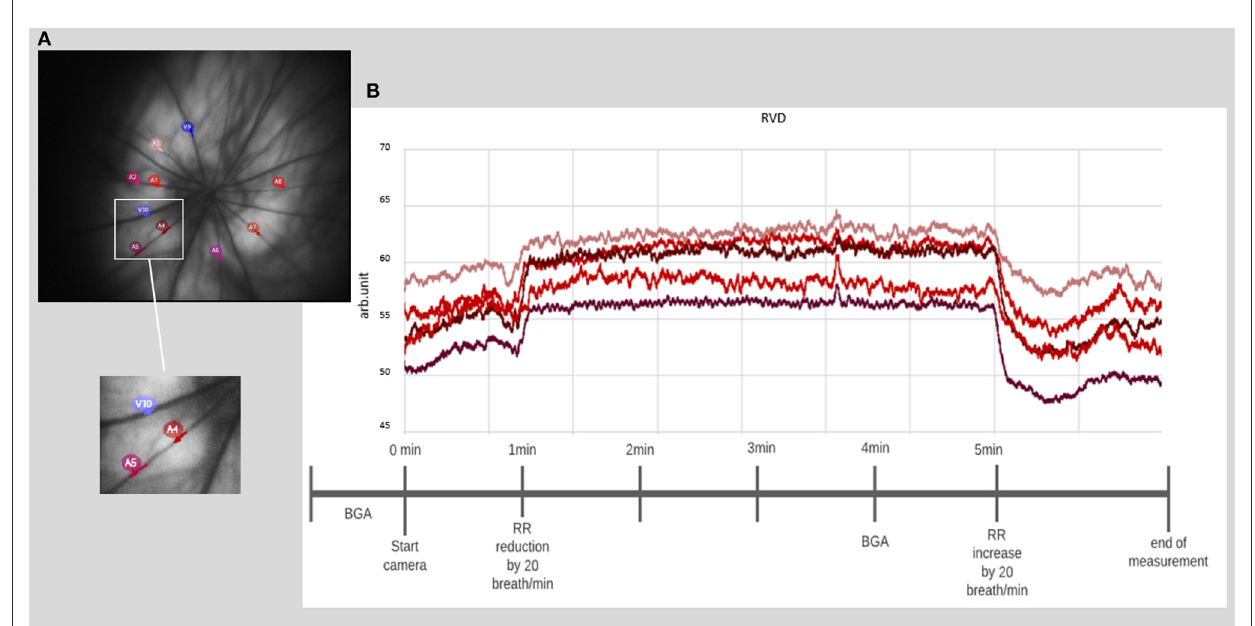
FIGURE4 Retinal vessel diameter measurement. (A) Example of a fundus image with the selection of 10 different vessel segments. (B) Example of a time course of chosen vessel segments, with a prominent increase of the diameter directly after the onset of induced hypercapnia at 1min, lasting until hypercapnia is ended at 5min (BGA: blood gas analysis and RR: respiratory